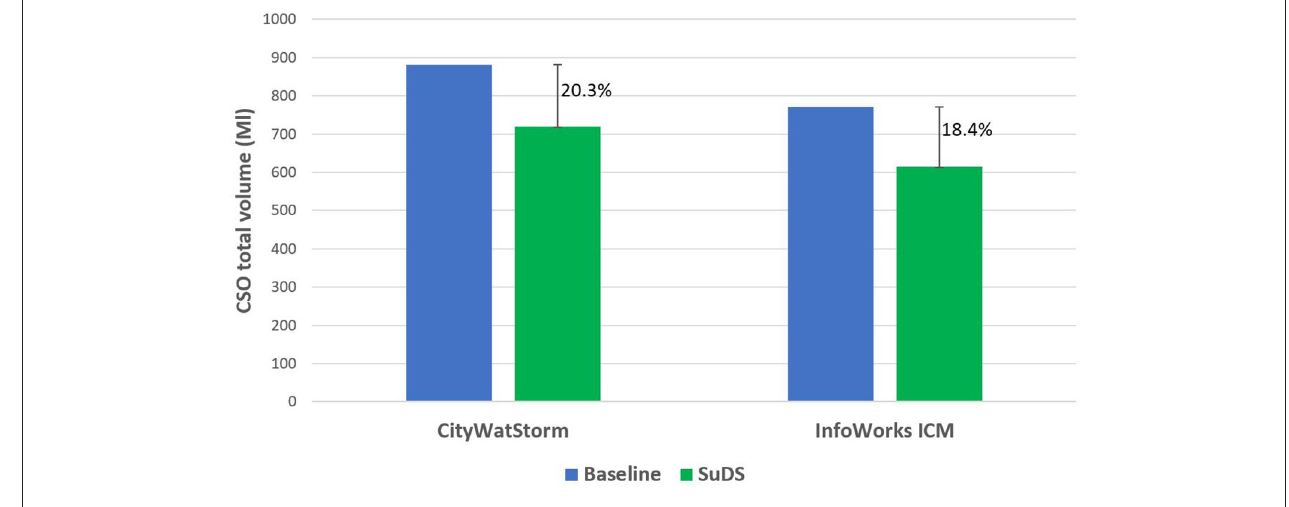
FIGURE 8 | SuDS implementation – Total CSO volume